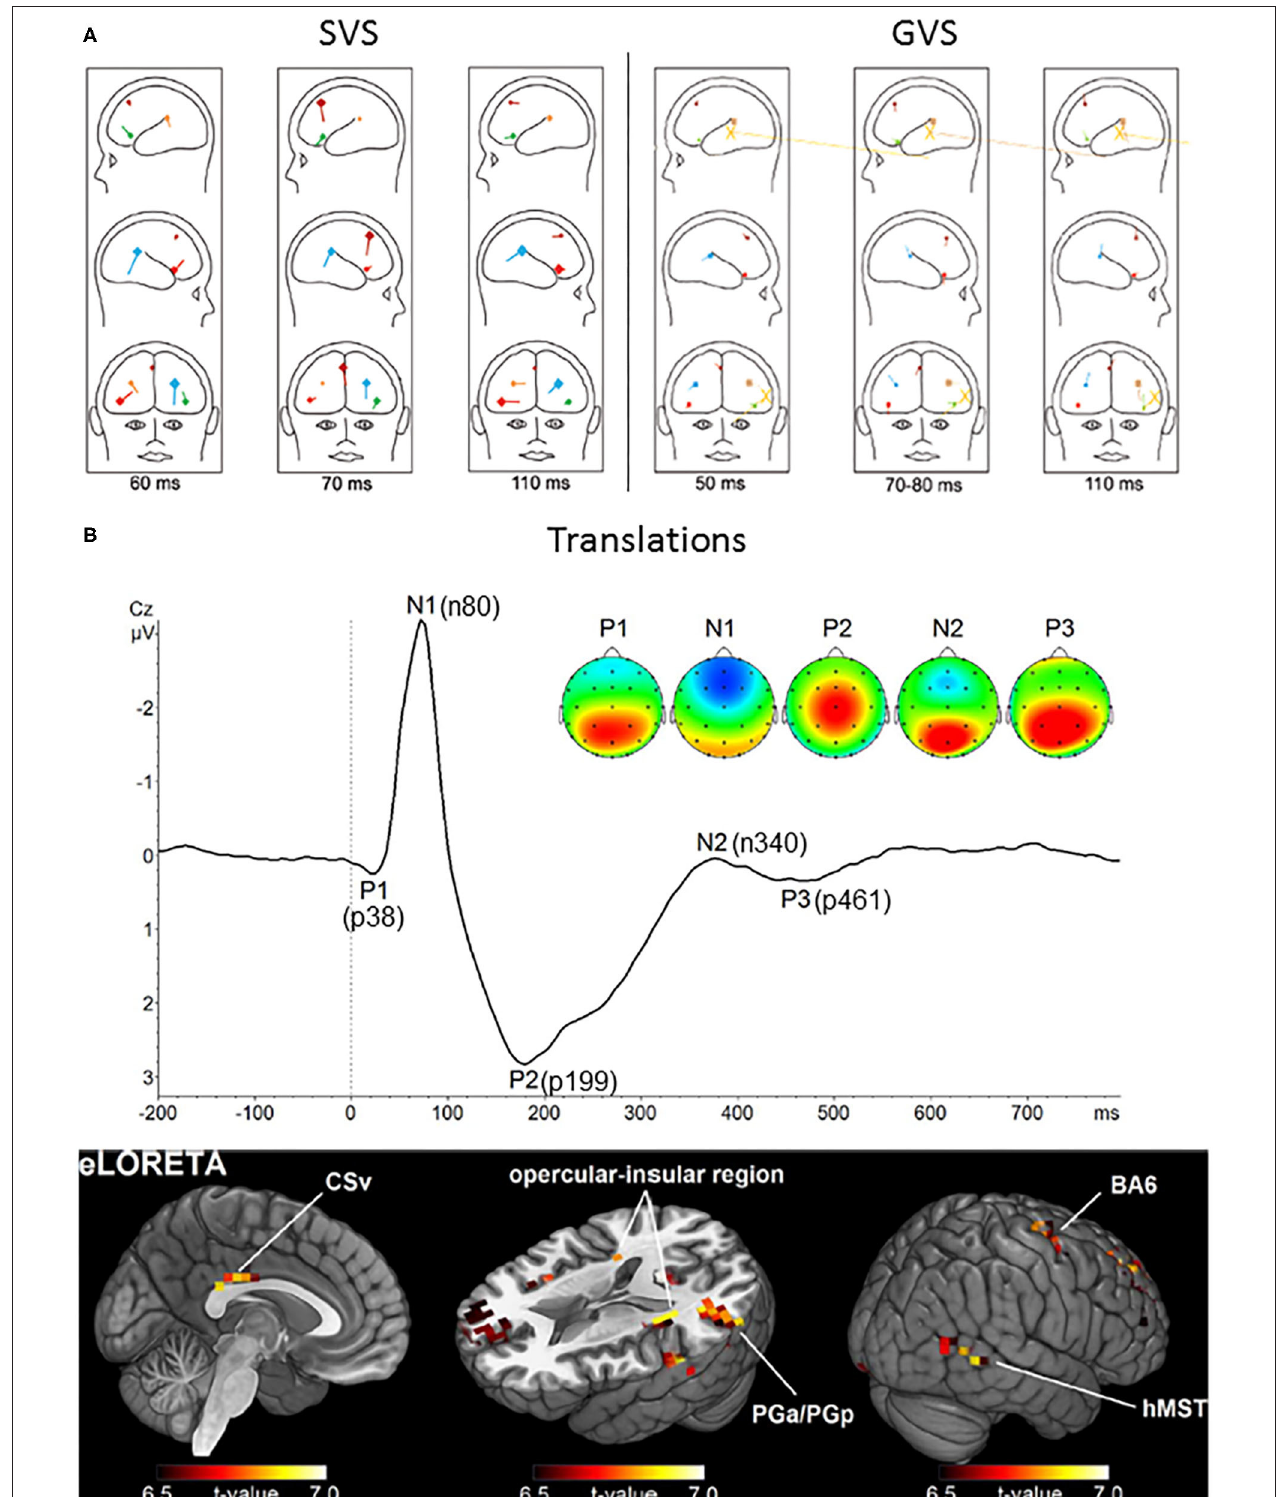
FIGURE 5 | Long latency vestibular-evoked cerebral potentials (VestEPs). (A) Sources of evoked potentials observed after SVS (left) and GVS (right). For SVS, BESA regional source activity projected to a head showing the junction of the anterior insula with the inferior frontal gyrus in the right hemisphere (bright red), the posterior parietal operculum (bright blue), a frontal source near areas 2v, 3aNV, and the frontal eye fields (dark red), the left inferior frontal gyrus (green), the left parietal